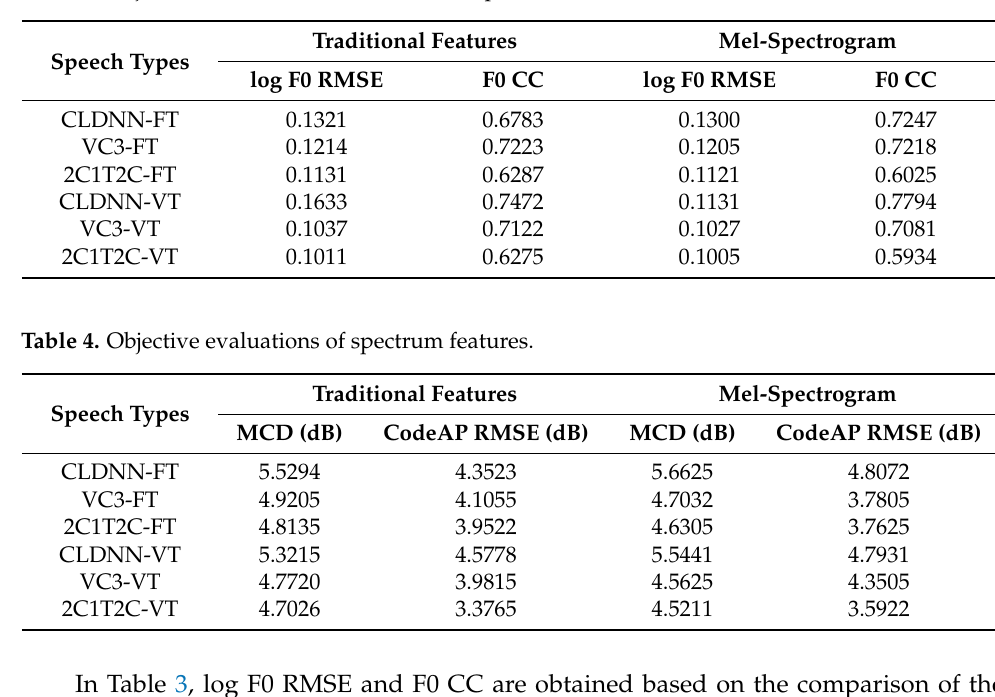
Table 3. Objective evaluations of converted F0 pattern.